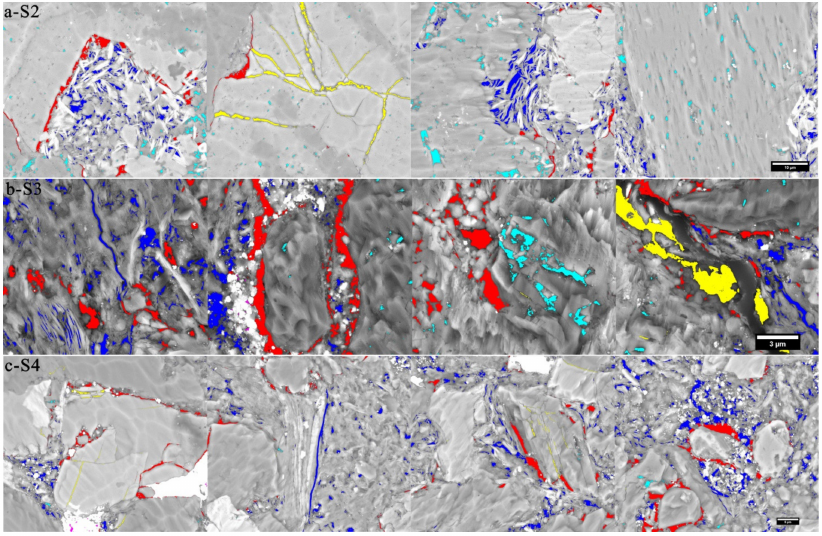
Figure 5. Pore identifications in felsic-rich shales: ( a ) S2; ( b ) S3; ( c ) S4. Red represents interparticle pores, blue represents intraparticle pores, cyan represents dissolution pores and yellow represents